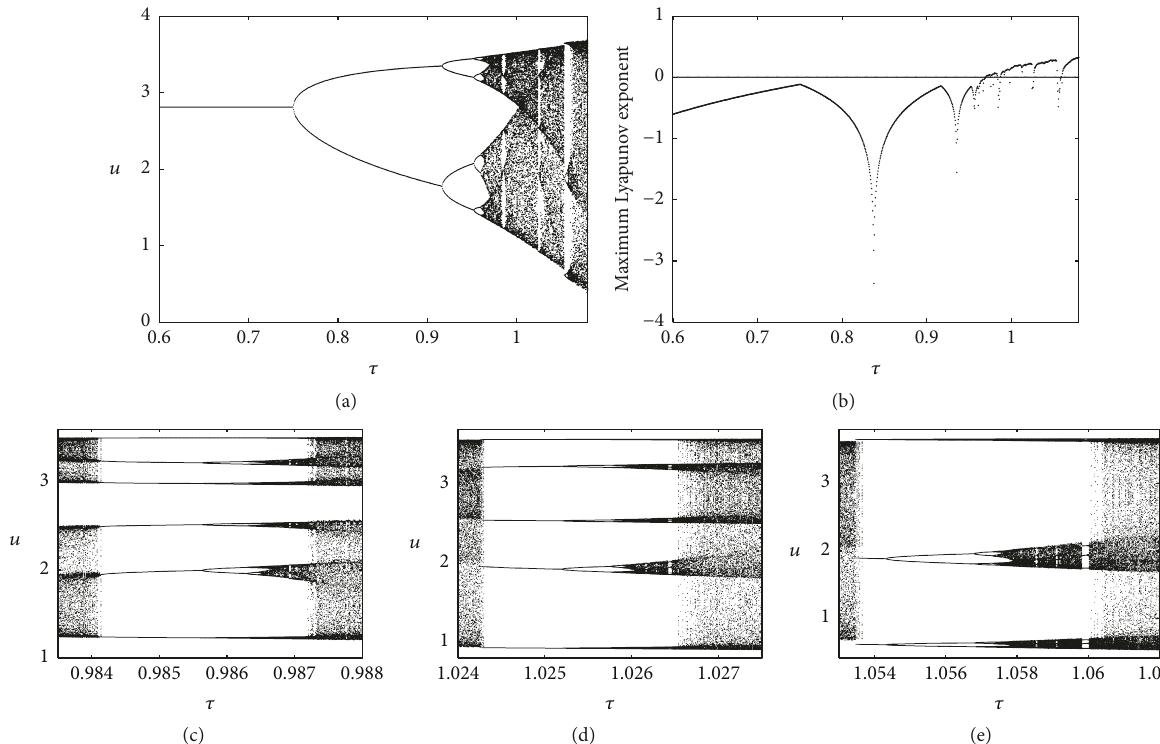
Figure 1: (a) Flip bifurcation diagram with 𝜏 covering [0.6, 1.08] ; (b) maximum Lyapunov exponent corresponding to (a); (c)–(e) local amplifications of (a) showing periodic windows. 𝑎 = 3 , 𝑏 = 2 , 𝑐 = 0.2 , 𝑑 = 1 , 𝛼 = 1 , and 𝛽 = 2